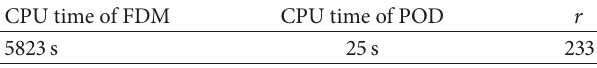
Table 6: Computational time comparison for real